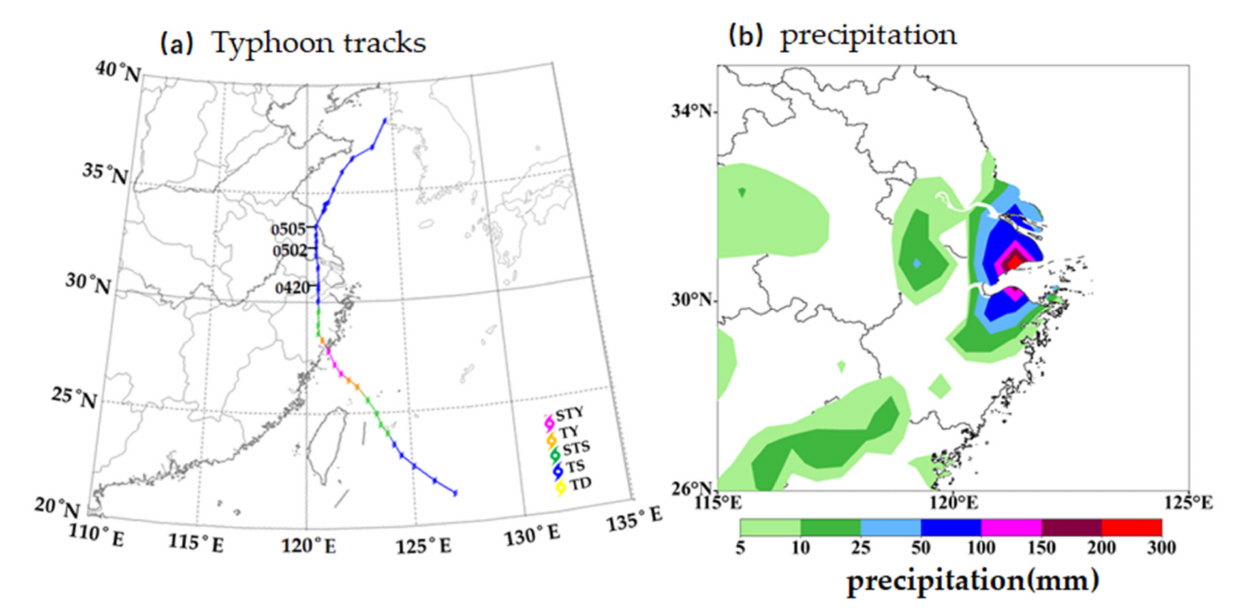
Figure 1. The tracks of Typhoon No. 4 “Hagupit” in 2020, the text in the picture indicates the Beijing time of the typhoon’s location (Figure 1a). The observed 24 h rainfall from 20:00 BT 4 to 20:00 BT 5 August 2020 (Figure 1b, shaded area, unit: